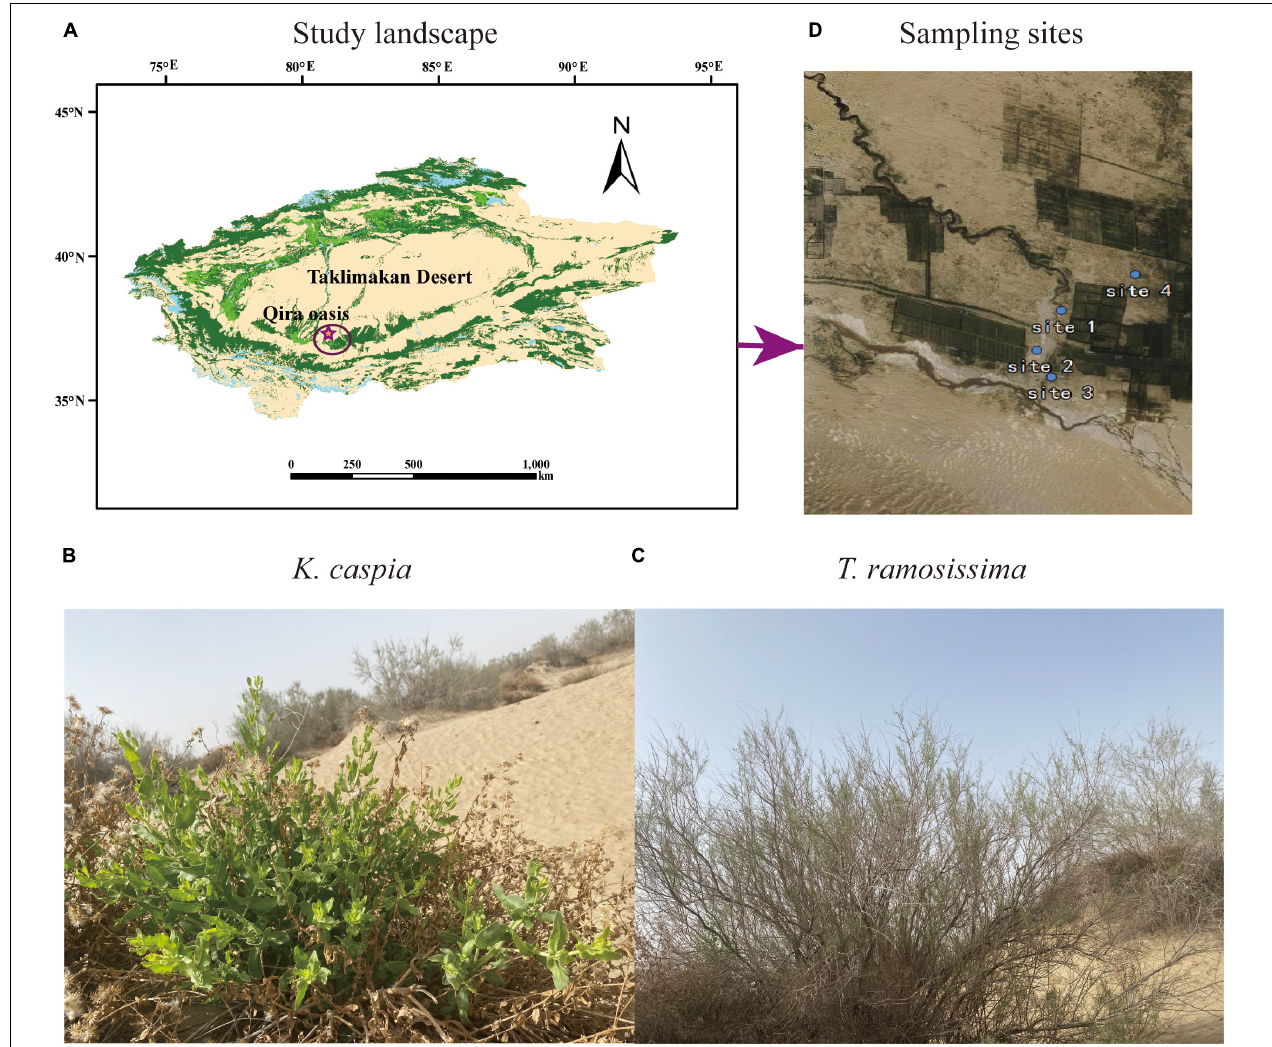
FIGURE 1 | Photos of the study landscape (A) , desert species Karelinia caspia (K. caspica) (B) , Tamarix ramosissima (T. ramosissima) (C) , and four sampling sites (D)